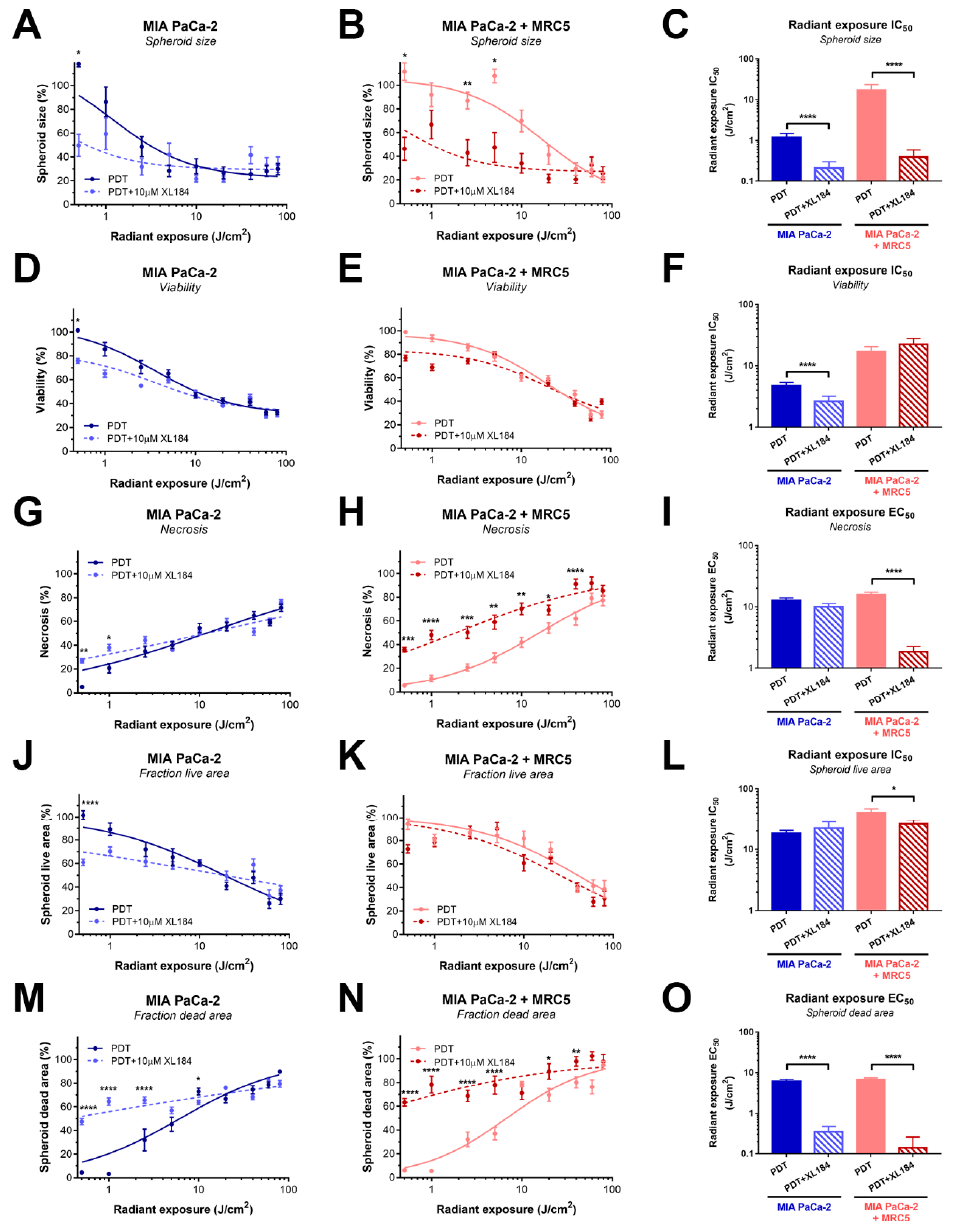
Figure 6. Cabozantinib augments the capacity of PDT to reduce spheroid sizes and elevate necrosis in MIA PaCa-2 and MIA PaCa-2+MRC5 spheroids. ( A–C ) The effect of cabozantinib on the PDT efficacy based on the size of MIA PaCa-2 spheroids (A), MIA PaCa-2+MRC5 spheroids (B), and a statistical comparison of the fitted IC 50 values (C). ( D – F ) The effect of cabozantinib on the PDT efficacy based on the viability of MIA PaCa-2 spheroids (D), MIA PaCa-2+MRC5 spheroids (E), and a statistical comparison of the fitted IC 50 values (F). ( G–I ) The effect of cabozantinib on the PDT efficacy based on overall necrosis in MIA PaCa-2 spheroids (G), MIA PaCa-2+MRC5 spheroid (H), and a statistical comparison of the fitted EC 50 values (I). ( J–L ) The effect of cabozantinib on the PDT efficacy based on the fractional live area of MIA PaCa-2 spheroids (J), and MIA PaCa-2+MRC5 spheroids (K), and a statistical comparison of the fitted IC 50 values (L). ( M–O ) The effect of cabozantinib on the PDT efficacy based on the fractional dead area of MIA PaCa-2 (GM), and MIA PaCa-2+MRC5 spheroids (N), and a statistical comparison of the fitted EC 50 values (O). All data are the mean ± SEM from N = 8–36 from ≥ 3 technical repeats. The error in IC 50 values represents the SD. Statistical significance is indicated as * p < 0.05, ** p < 0.01, *** p < 0.005, or **** p <